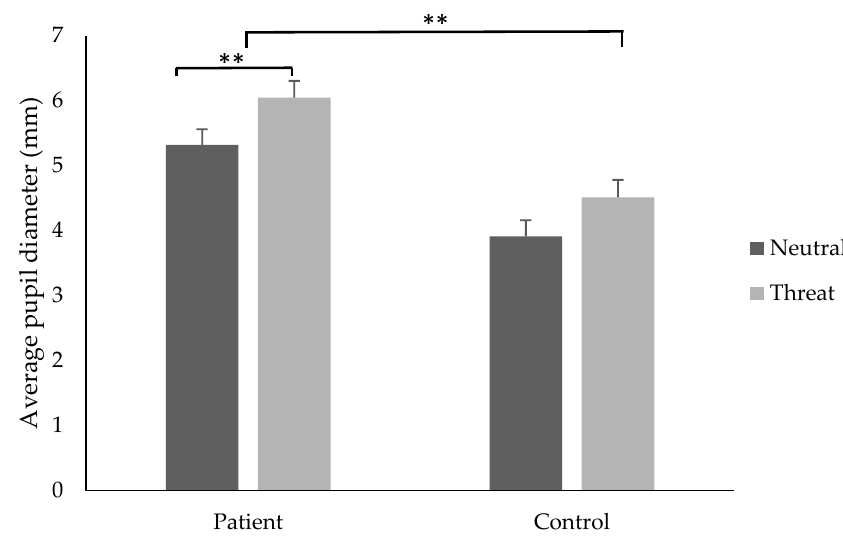
Figure 3. The average pupil diameter (mm) (±SE) for the patient and control groups when attending to threatening and neutral stimuli. ** indicates p < 0.01.